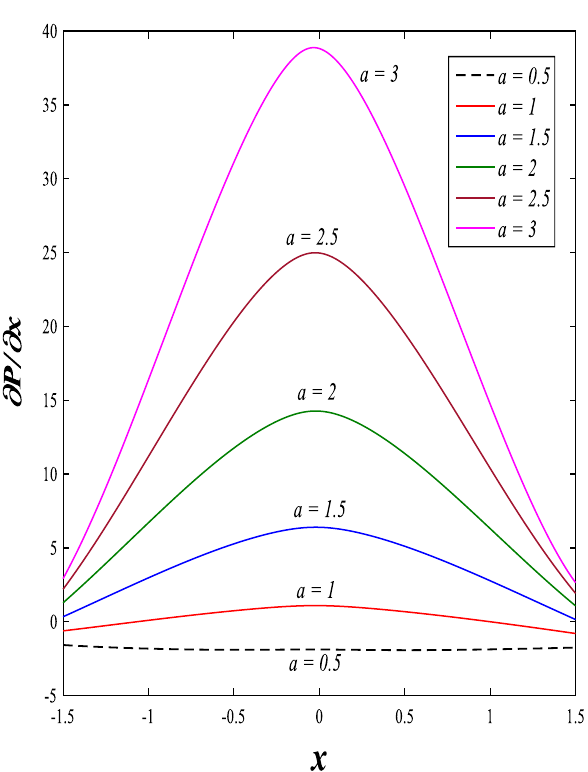
Figure 29. Effect of the half-channel width parameter a on the pressure gradients